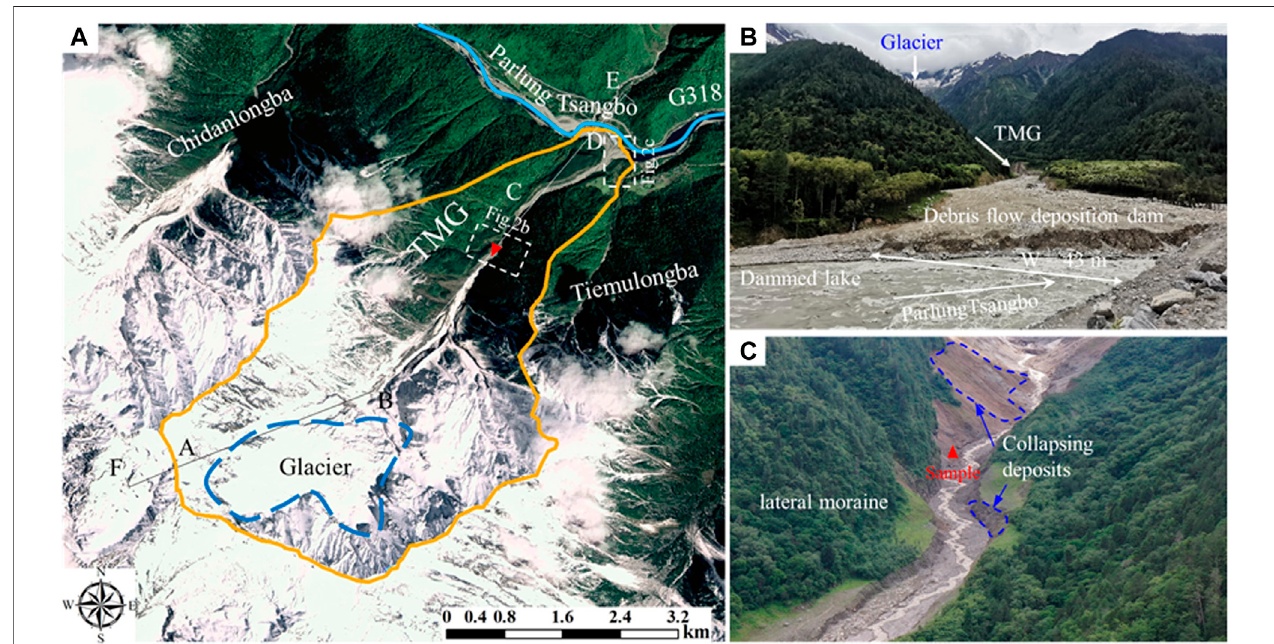
FIGURE 1 | Satellite image of the Tianmo gully (A) ; The scene of the 2020 debris fl ow event in Tianmo gully (B) ; Example of collapsed glacial tills and sample location (C) .